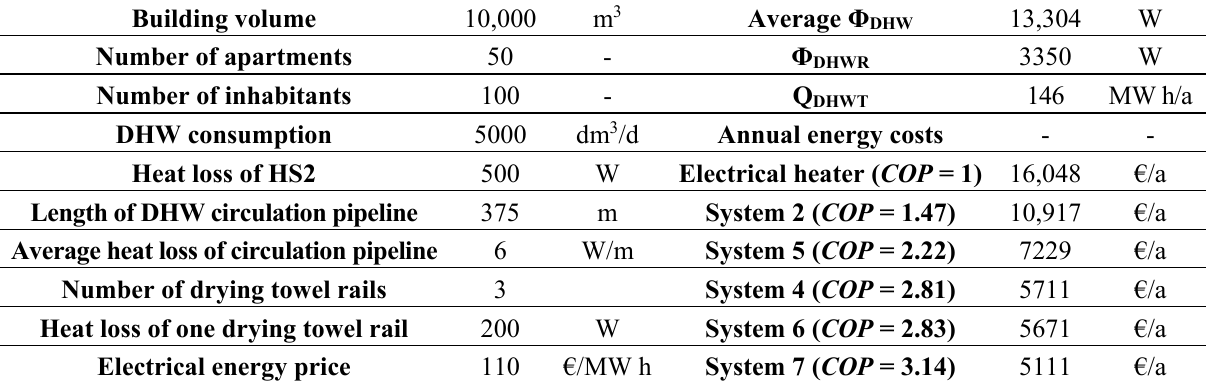
Table 2. The DHW production energy costs with different heat pump